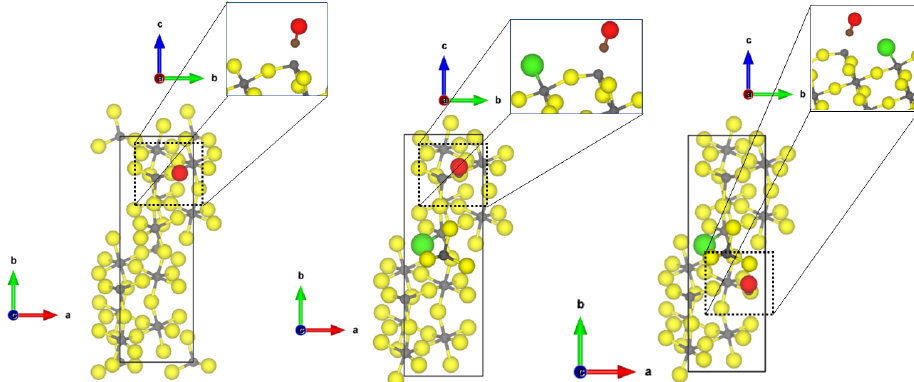
Figure 6. PBE-D3(BJ)-optimized structures of the probe molecule CO on the α -AlF 3 - ( left ) and Cl- doped α -AlF 3 -(10¯12) ( middle and right ) surface. yellow = fluorine, grey = aluminium, brown = car- bon, red = oxygen.